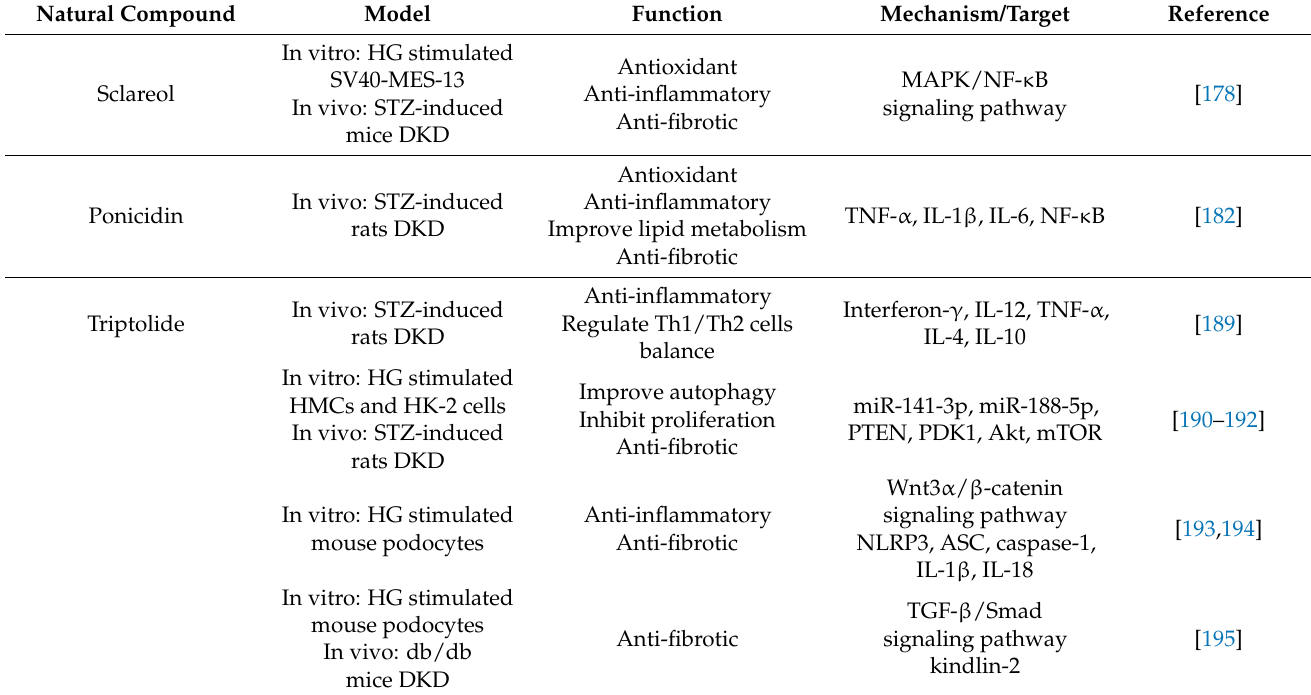
Table 4. Mechanisms of terpenoids in the treatment of